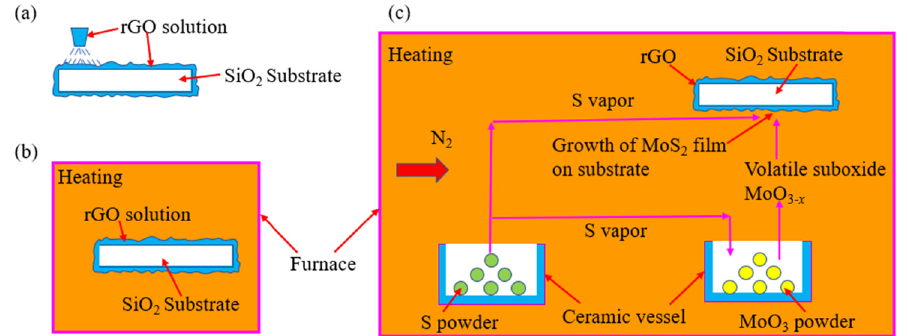
Figure 4: The principle of chemical vapor deposition for synthesizing MoS 2 nanosheet based on the reaction between sulfur ( S ) and molyb - denum oxide ( MoO 3 ) at elevated temperature. ( a ) The rGO solution is spun on the surface of the SiO 2 substrate. ( b ) The rGO solution is dried in a furnace at 50°C. ( c ) The sulfur ( S ) powder and molybdenum oxide ( MoO 3 ) powder are put in a furnace at 650°C in a nitrogen